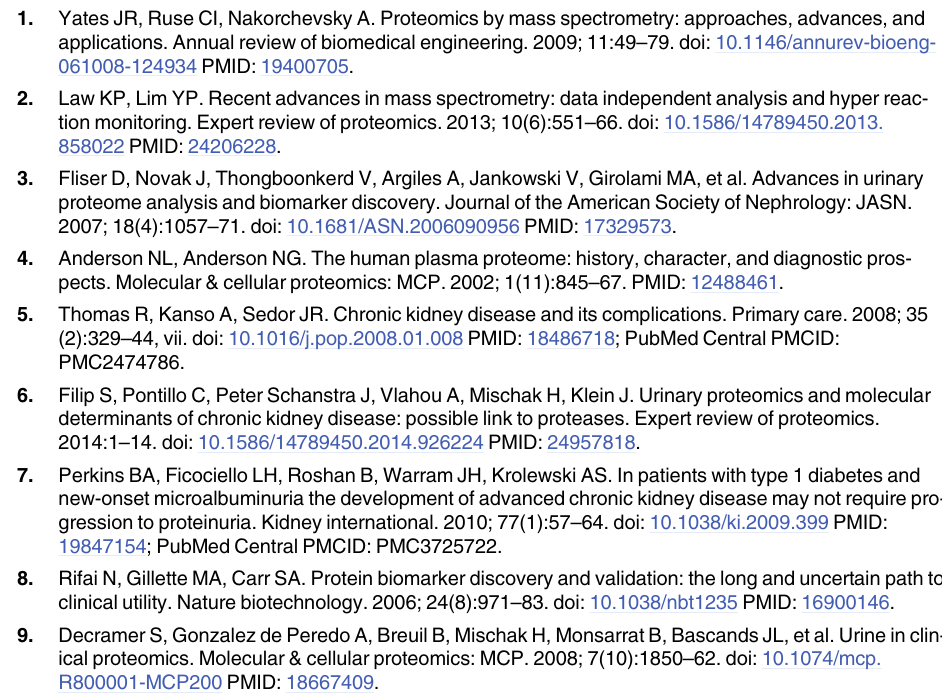
S14 Fig. Changes in protein abundance for overlapping identifications between ProteoSpin depleted sample and initial urine. The scatterplots present the protein relative abundance changes after protein depletion in comparison to the initial sample. X axis represents the nor- malized protein abundance for initial urine in logarithmic scale (log scale) above a ratio of 0 are enriched in comparison to initial urine, while those below the 2 ratio of 0 are depleted. Proteins with a ratio 0 show the same relative abundance in the initial and depleted sample. Protein abundance for immunoglobulins is presented as a sum of the abundance for all combined proteins in the group. Protein targets for depletion kit are marked as red dots (see Table 1). Protein targets for which the relative abundance increased after deple- tion are marked by an